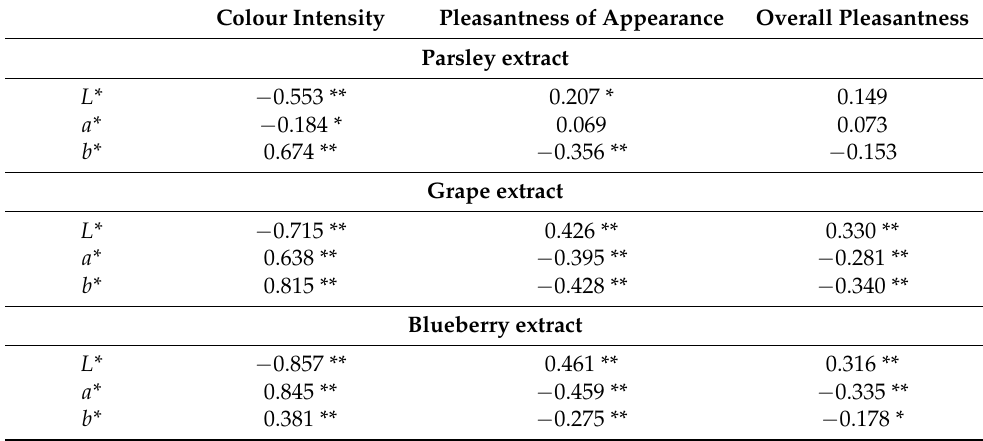
Table 7. Spearman’s correlation coefficients between sensory appearance descriptors and instrumen- tal colour parameters of edible coating samples with added plant